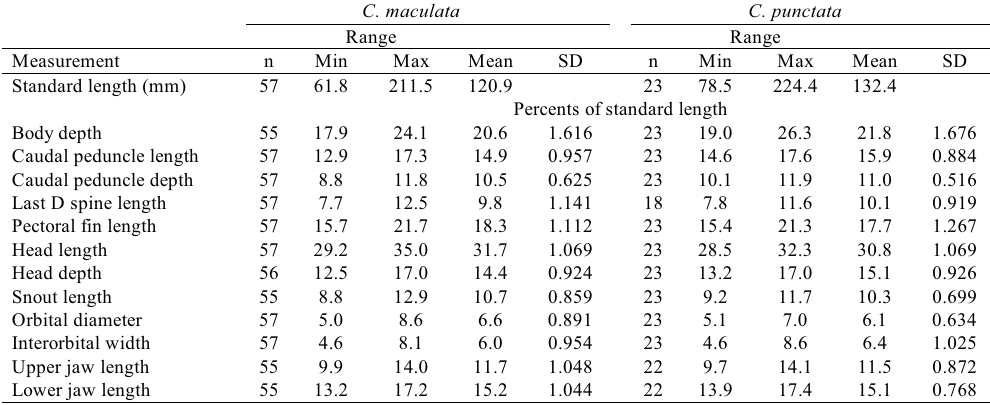
Table 3. Morphometry of Crenicichla maculata and C. punctata . SD= Standard